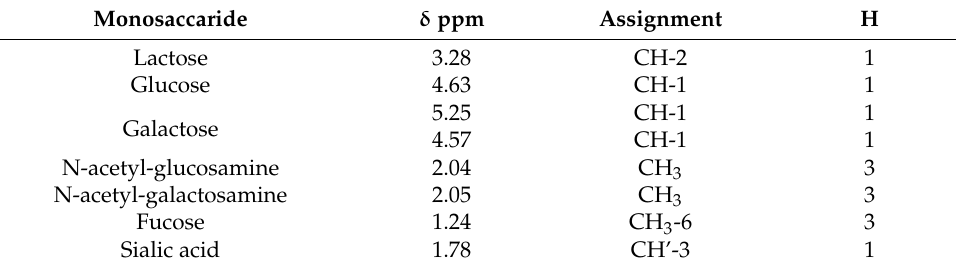
Table A2. Assignments of NMR signals used for quantification in